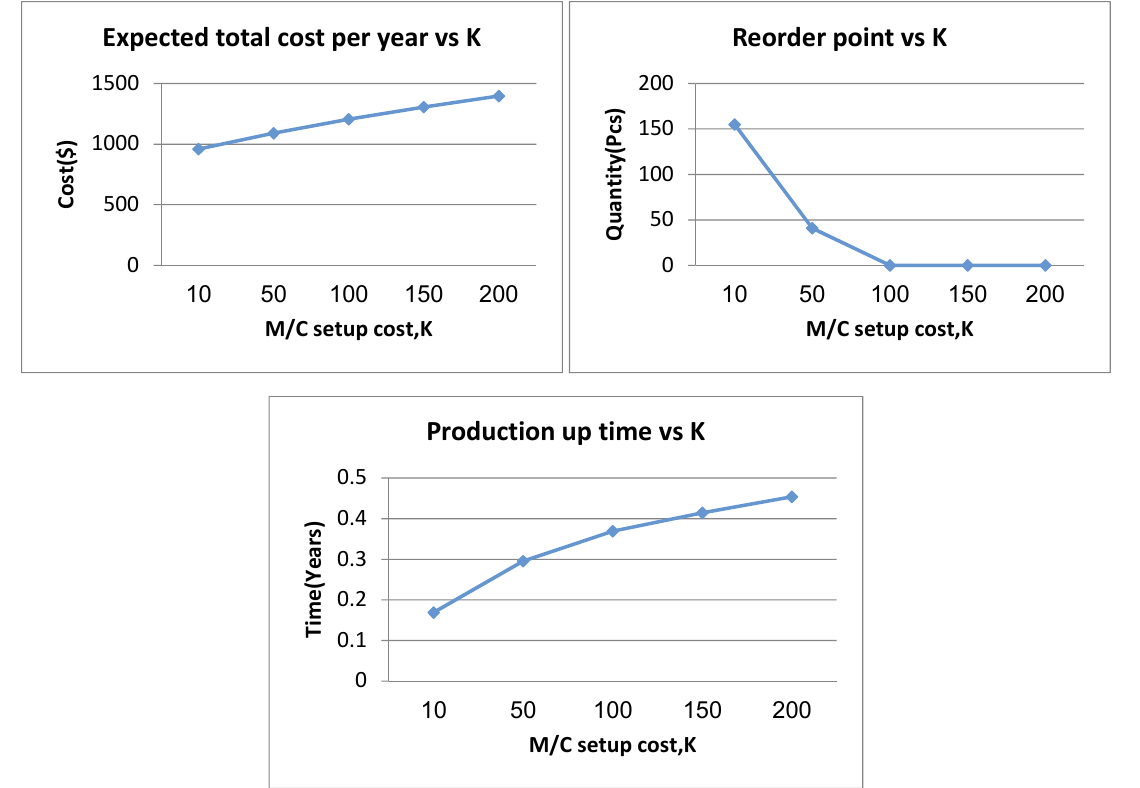
Fig. 13. Expected total cost per year, up time & reorder point for different value of K